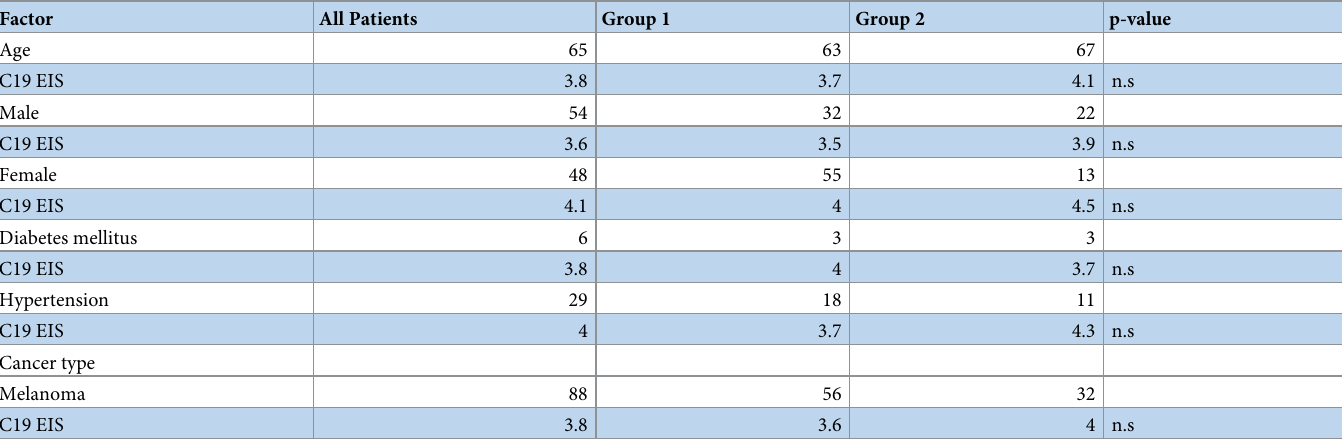
Table 2. Results of the Covid-19 Emotional Impact Survey (C-19EIS). Factor